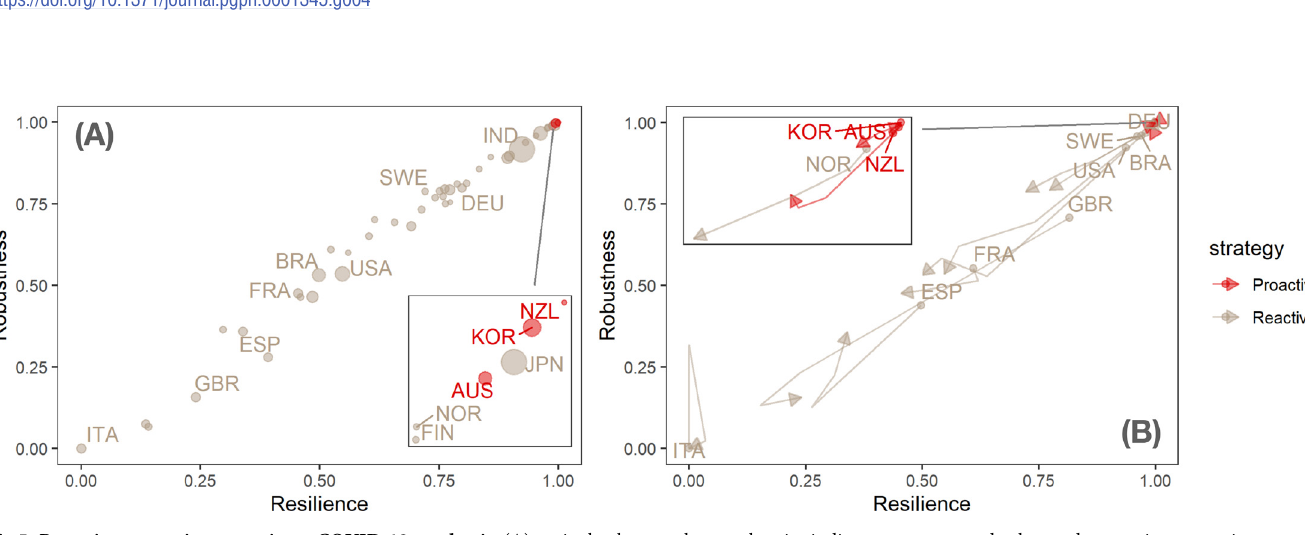
PLOS Global PublicHealth | https://doi.org/10.1371/journal.pgph.0001345 January24,